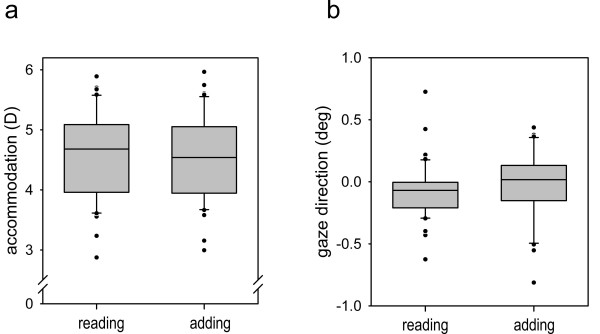
Box-and-Whisker Plots of the results of experiment 1. In a. the accommodation response (D) and in b. the gaze direction (deg) as function of task (reading & adding) are shown; both were statistically significant but – as shown in the Appendix – not independent of each other: the measured change in accommodation was mainly induced by the observed change in gaze direction.